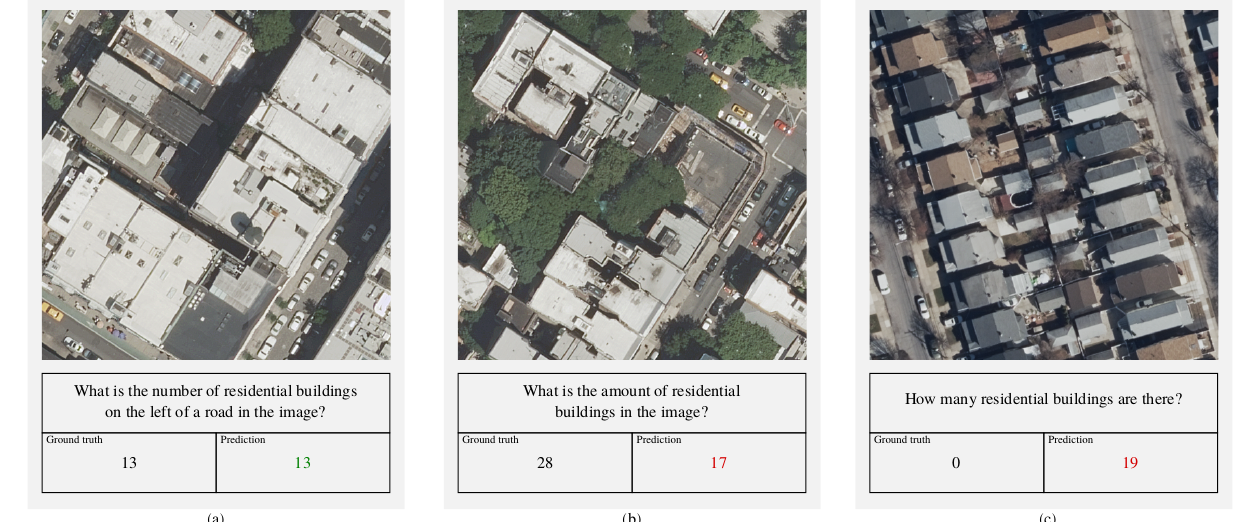
Figure 6. Predictions of the proposed model on the test